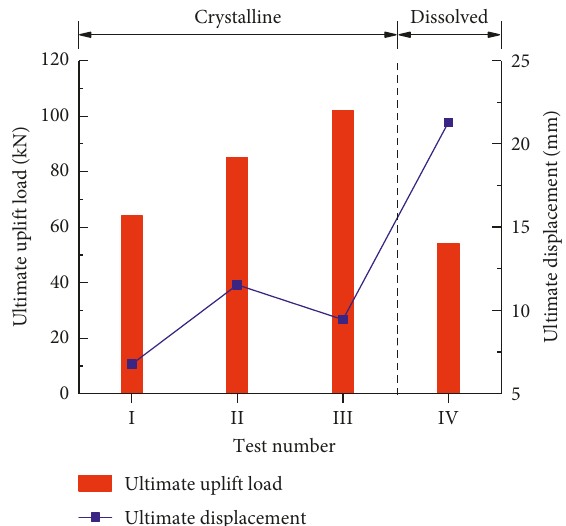
Figure 9: Comparison of both ultimate uplift bearing capacity and displacement.